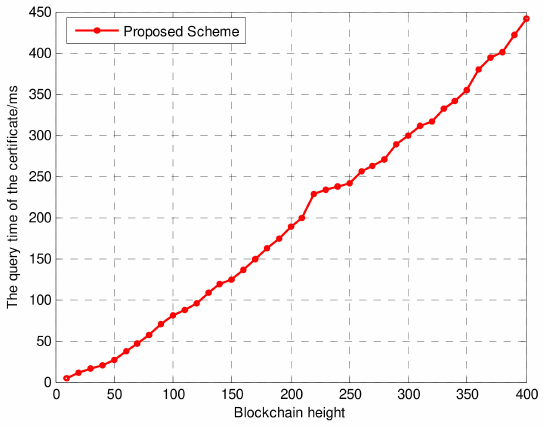
Figure 10. The query time for certificates.